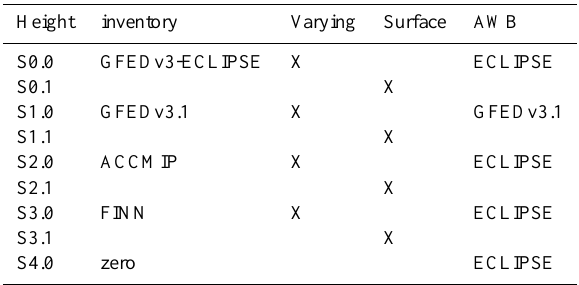
Table 4. Summary of simulations performed for this